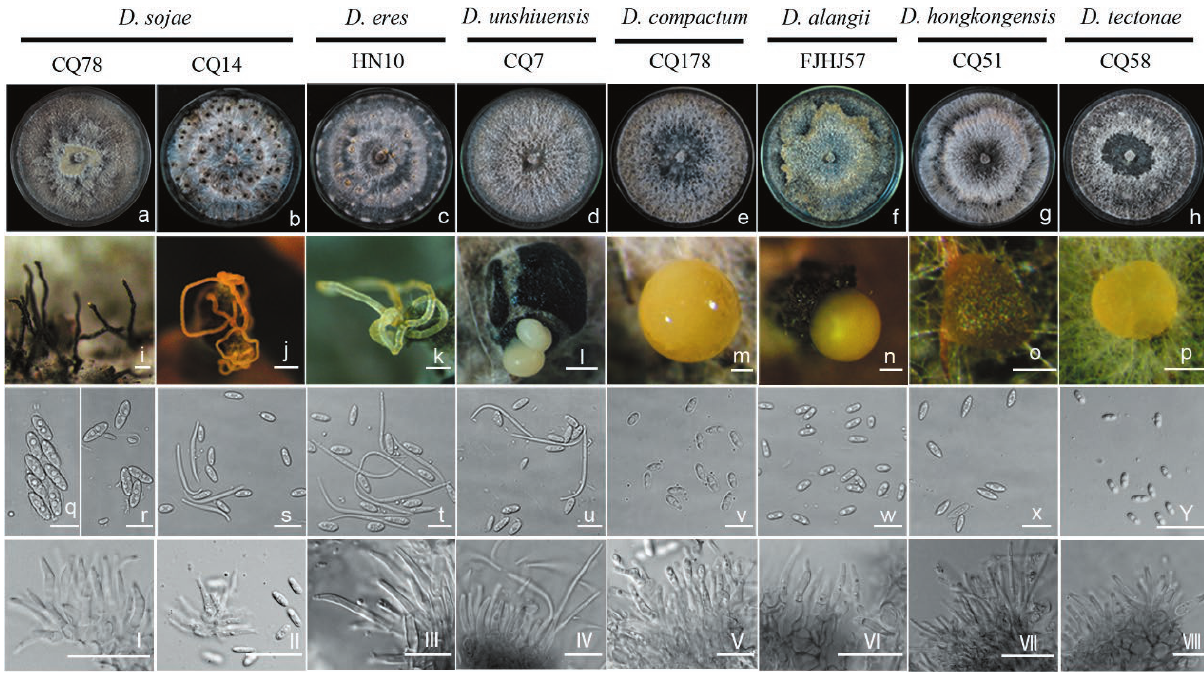
Figure 4. Morphologies of representative isolates selected from seven Diaporthe species. a to h, colony characteristics of the representative iso- lates of belonging to seven species cultured on potato dextrose agar incubated at 25°C in darkness. i, ascomata on fennel stems. j and k, spiral conidial cirri. l to p. conidial droplets. q, asci. r, ascospores. s to u, alpha and beta conidia. v to y, alpha conidia. I-VIII, conidiophores. Scale bars: i, k and n = 200 μm; j and l = 500 μm; m, o and p =100 μm; q to y = 10 μm. I to III and VI to VII = 20 μm; IV, V, and VIII =10